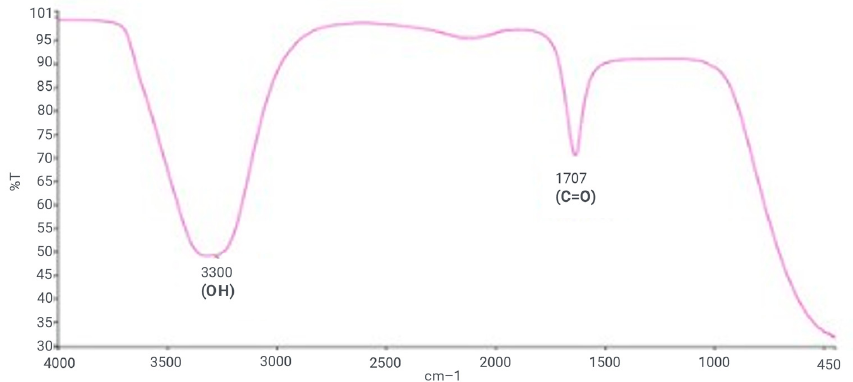
Figure 2. FT-IR Spectrum of ZnO NPs from aqueous fraction of L. edodes.